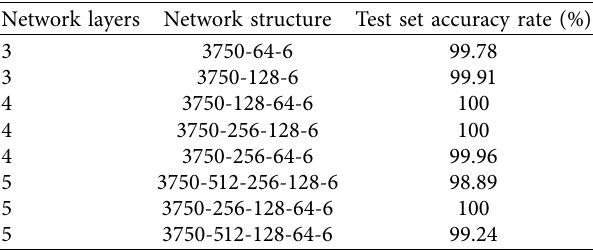
Table 4: SDAE accuracy under different network